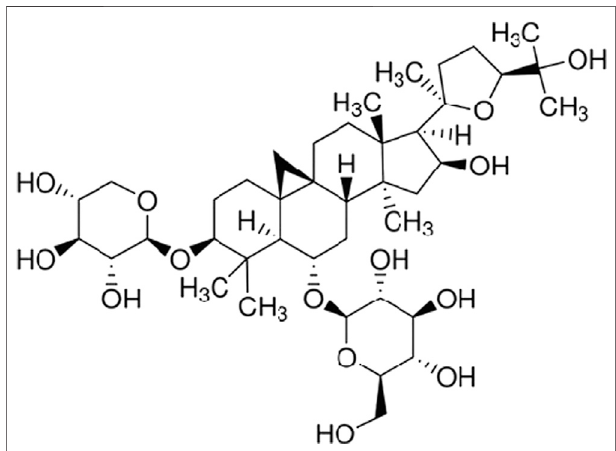
FIGURE 1 | Chemical structure of astragaloside